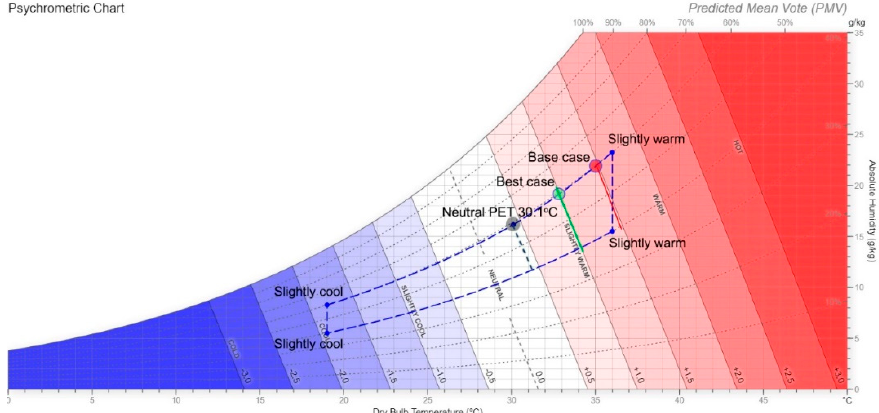
Figure 15. Psychometric chart summarises the study outputs where the comfort range (the blue dotted lines) compared against the ISO 7730:2005 [89] comfort range. The best case no. 6 (32.9 °C PET) and the base case no 2 (35.2 °C PET) are within the acceptable range however when compared to the ISO range; only the best case can be considered within the comfort range (slightly warm).